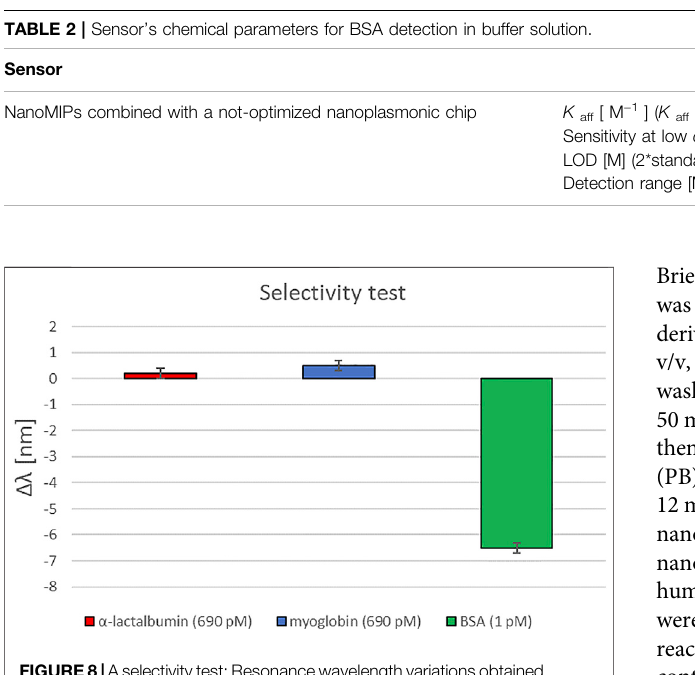
Frontiers in Bioengineering and Biotechnology |